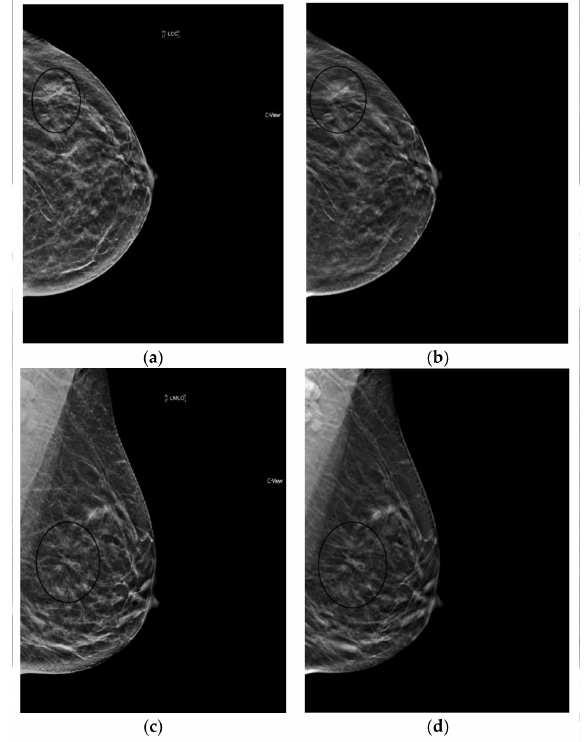
Figure 3. Architectural Distortion (circled in black) detected on screening mammogram with synthesized mammography and confirmed on tomosynthesis images (slices shown here), permitting confident Breast Imaging Reporting and Data System (BIRADS) 0 assessment. After diagnostic work-up and biopsy, pathology confirmed well-differentiated invasive ductal carcinoma, ER/PR+, Her2-, with grade 1 ductal carcinoma in situ. ( a ) s2D CC ( b ) DBT slice CC ( c ) s2D mediolateral oblique ( d ) DBT slice mediolateral